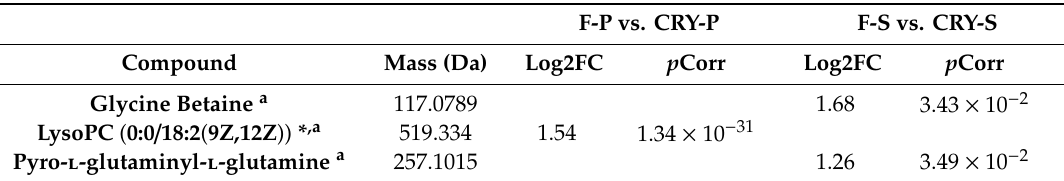
Table 1. Values of p Corrected and Log2Fold Change of putatively identified metabolites in fresh and cryopreserved seminal plasma (F-P and CRY-P) and fresh and cryopreserved spermatozoa (F-S and, CRY-S) samples ( t -test with p -value < 0.05 and fold change > 2.0).